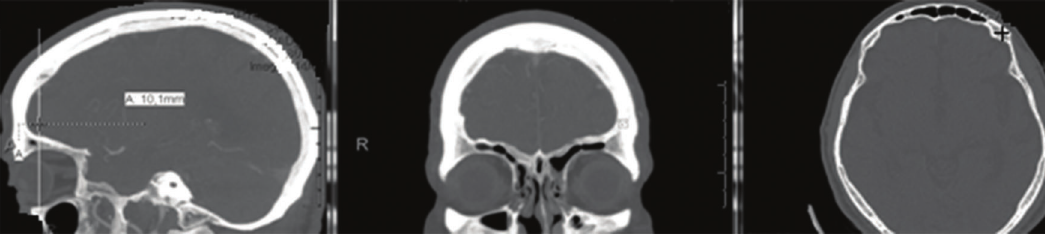
Figure 1 - Site of pin insertion via recognition line mode viewed in the sagittal cut and via locating mode viewed in the coronal cut. Images were generated by the software for the measurements of both internal and external border thickness, as shown by the cross in the axial